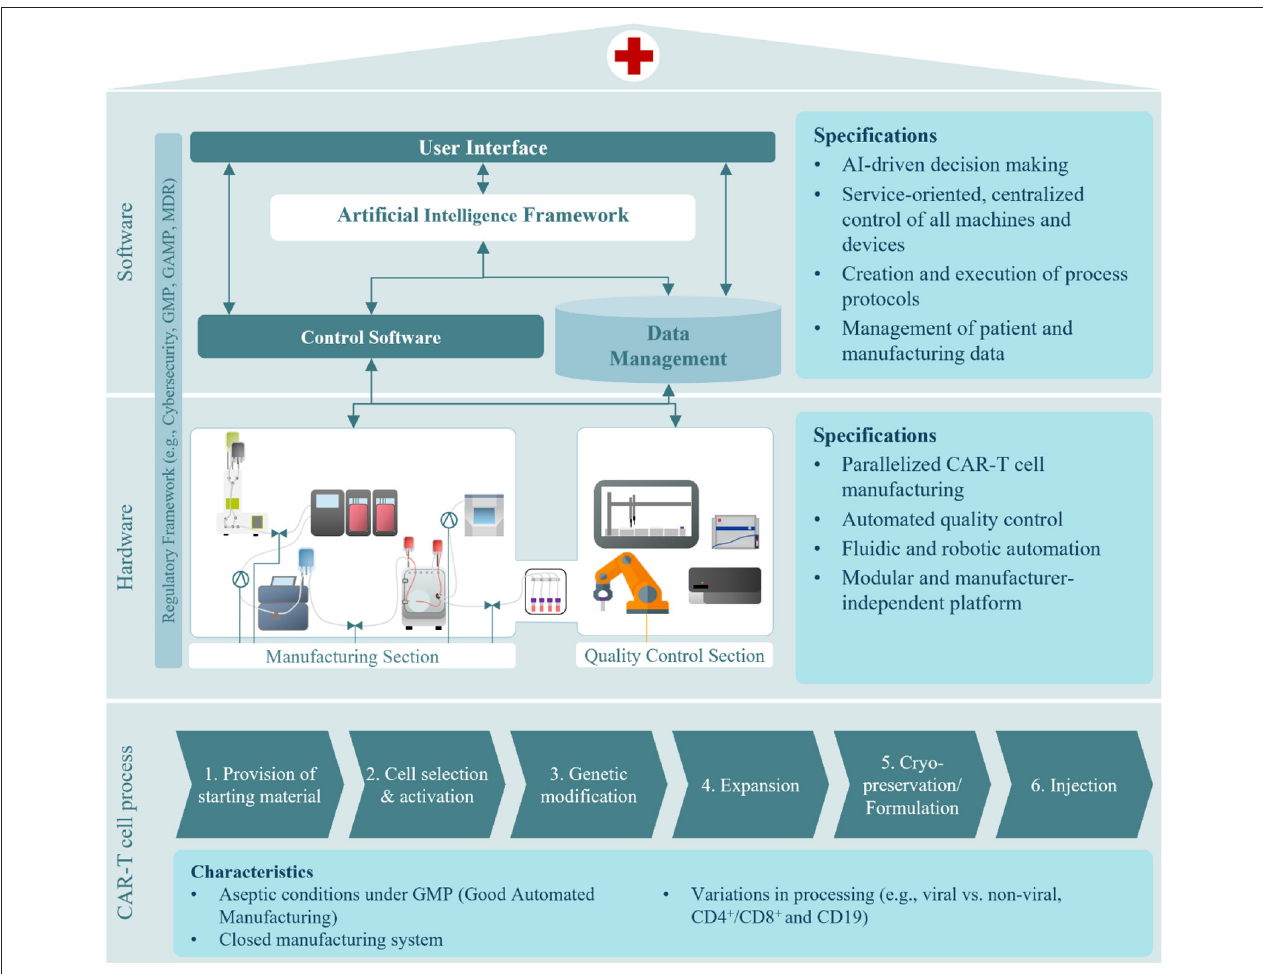
FIGURE 2 | Automated, AI-driven CAR-T cell manufacturing concept considering the CAR-T cell process, hardware, and software